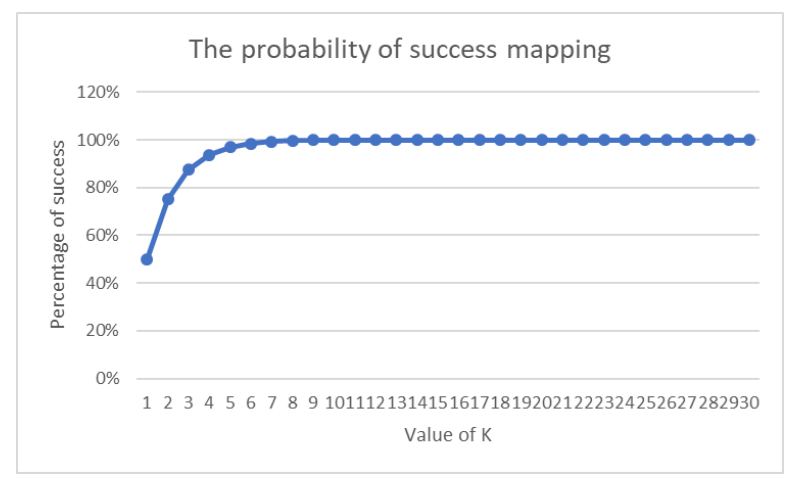
Figure 5. King’s [72] probability value of successful mapping.